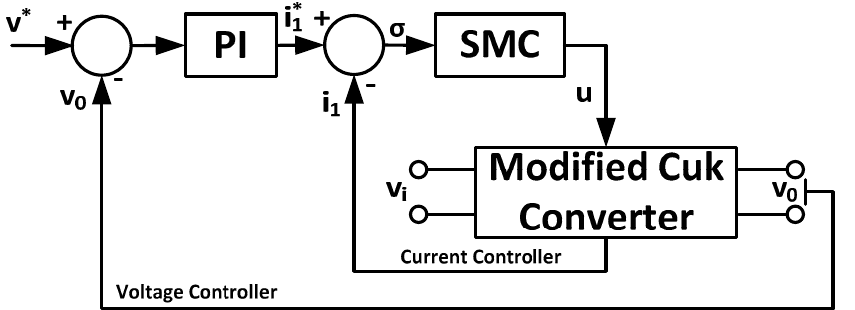
Figure 5. Cascaded control of modified Ć uk converter. PI: proportional integral; SMC: sliding mode controller.